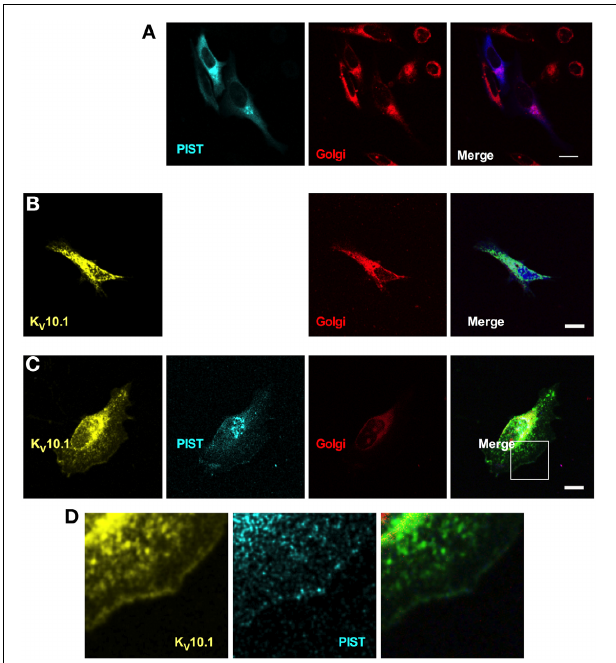
FIGURE 6 | Cellular distribution of K V 10.1_Venus and CFP-tagged PIST. CFP-PIST, when expressed alone (A) , reproduced from Figure 5 , gave a diffuse distribution with preferential location to the Golgi (stained in red). Overexpressed K V 10.1 showed a preferentially intracellular distribution (B) . When co-expressed (C) , both CFP-PIST and K V 10.1 were detectable at the cell periphery, compatible with an increase of membrane localization of both proteins. (D) represents a larger magnification of the area represented by a white square in the “merged” panel in (C) , Scale bar: 10 μ m.